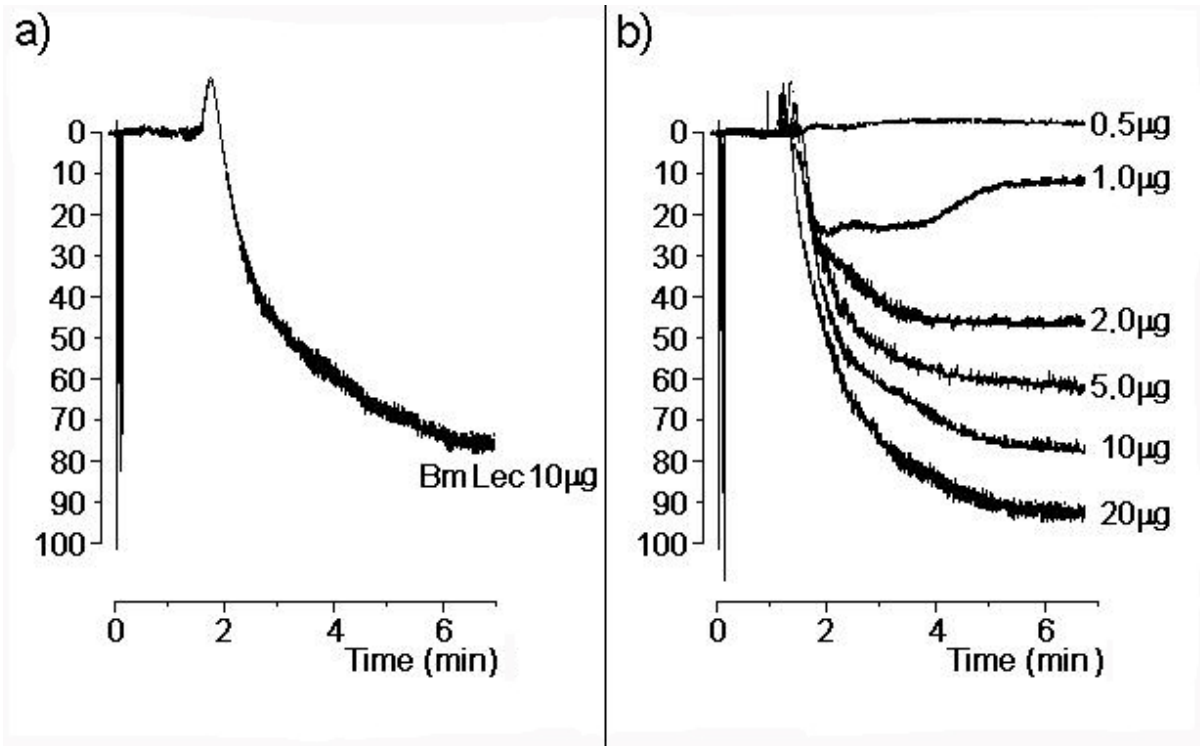
Figure 5. ( a ) Platelet aggregation induced BmLec. ( b ) Dose-dependent platelet aggregation induced by